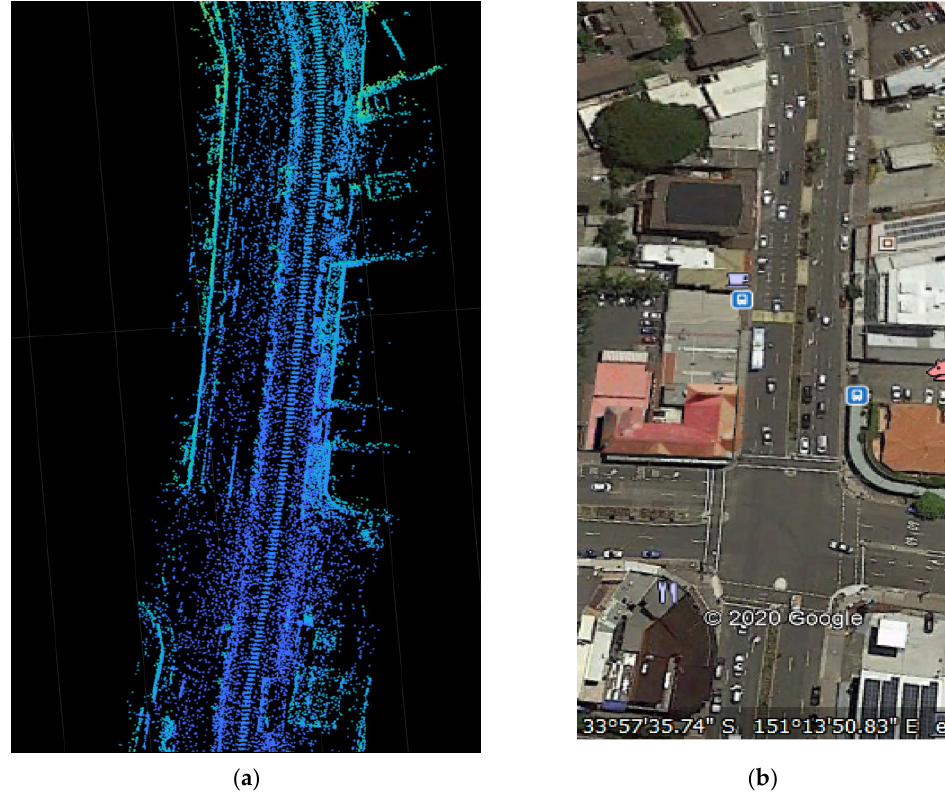
Figure 12. A section of ( a ) generated map, and ( b ) the Google Earth view for the same